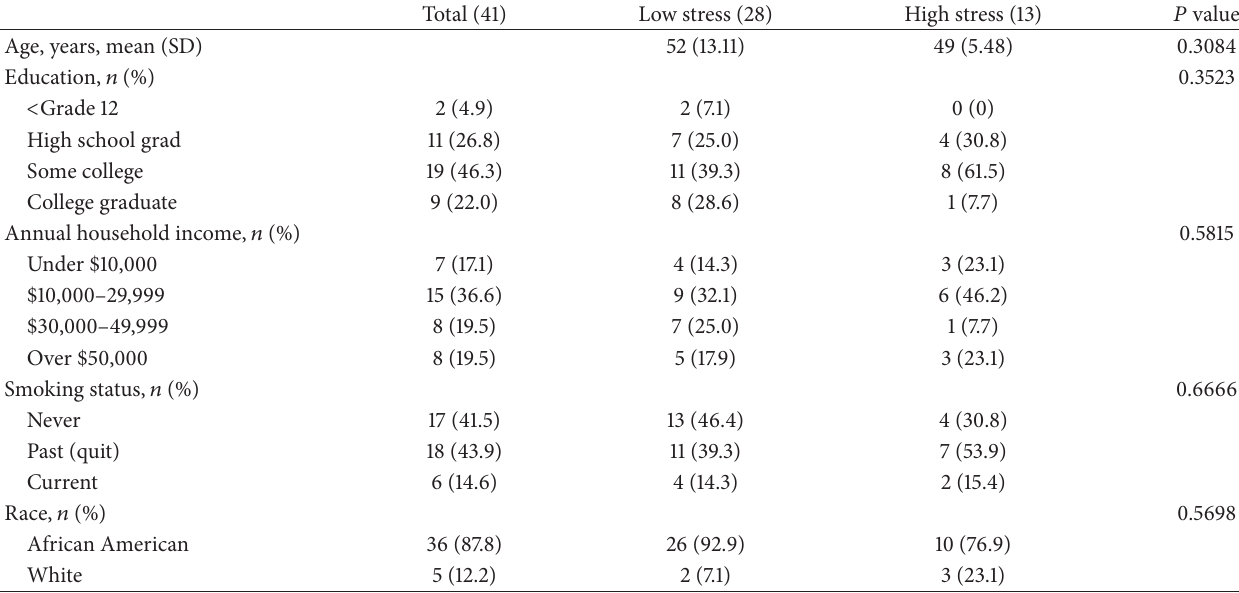
Table 1: Demographic characteristics of SLE cases in the Buffalo Lupus Project and Breakfast with a Buddy Biomarkers of Lupus Study ( 𝑁 = 41